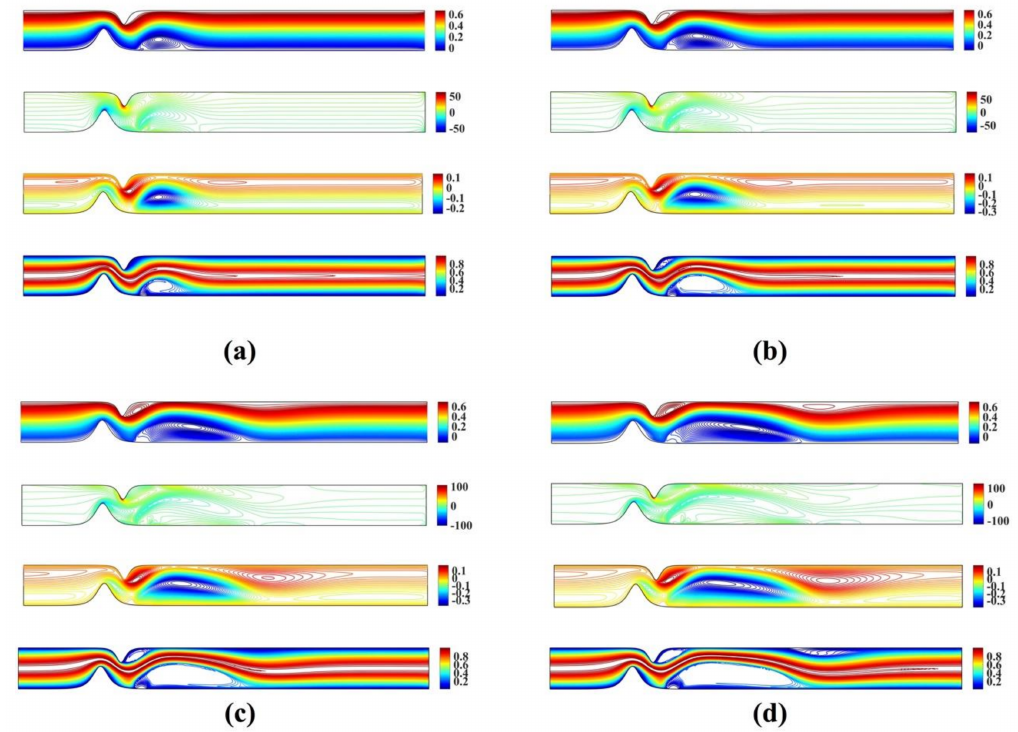
Figure 8. Streamlines, vorticity, microrotation contours and isotherms for the unsymmetrical single stenosis flow case using Mn F = 656, Mn M = 1.2, K = 2 and ( a ) Re = 50 ( b ) Re = 100 ( c ) Re = 200 and ( d ) Re =